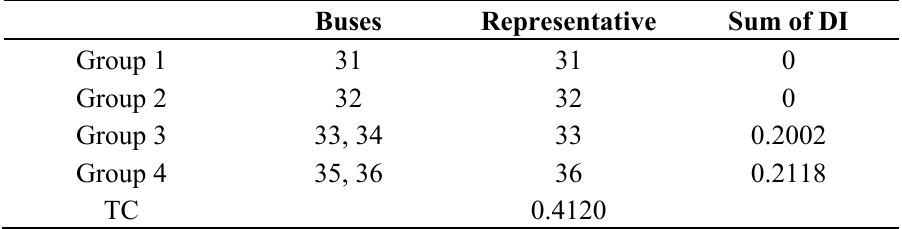
Table 2. Coherency identification result for the proposed algorithm.